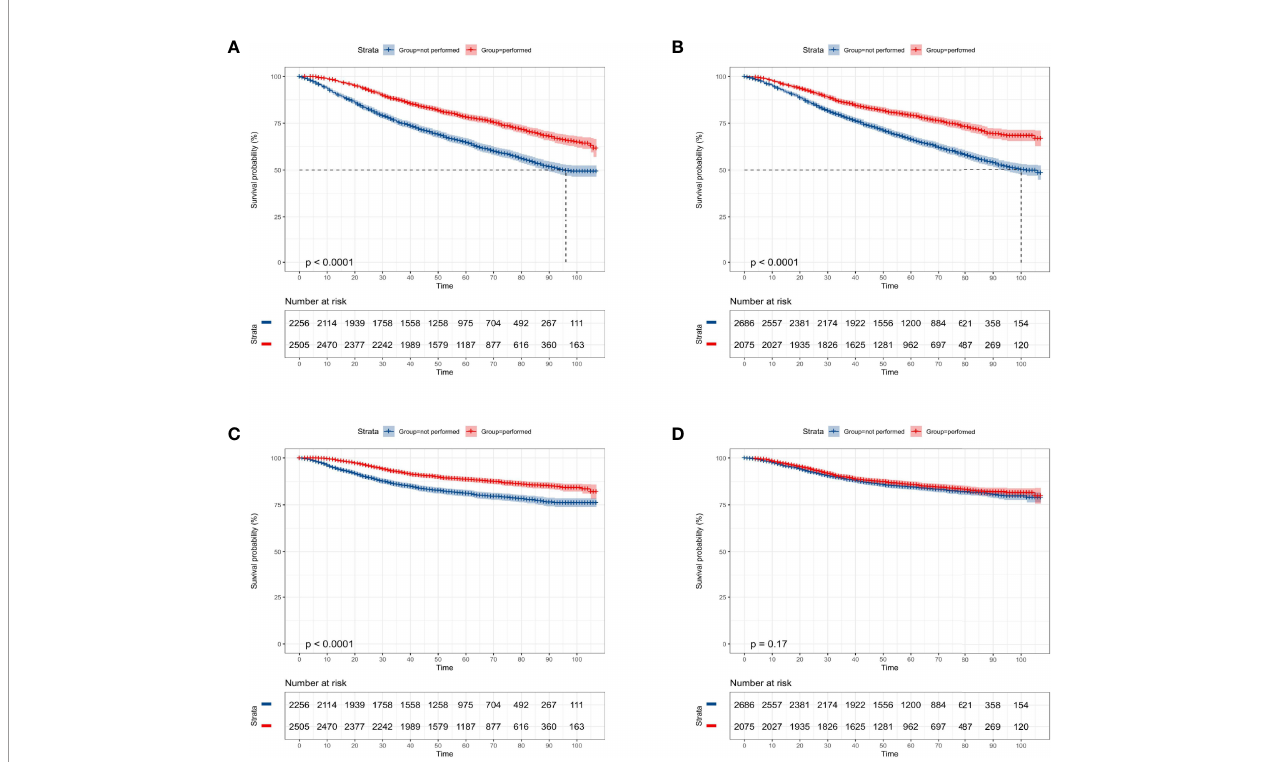
FIGURE 2 | Kaplan – Meier overall survival and cancer-speci fi c survival analyses of 4,761 women aged 70 years or older with primary operable, triple-negative breast cancer regarding the adjuvant treatment. (A) Radiotherapy for OS; (B) chemotherapy for OS; (C) radiotherapy for CSS; (D) chemotherapy for CSS. OS, overall survival; CSS, cancer-speci fi c survival. Tick marks indicate censored data.